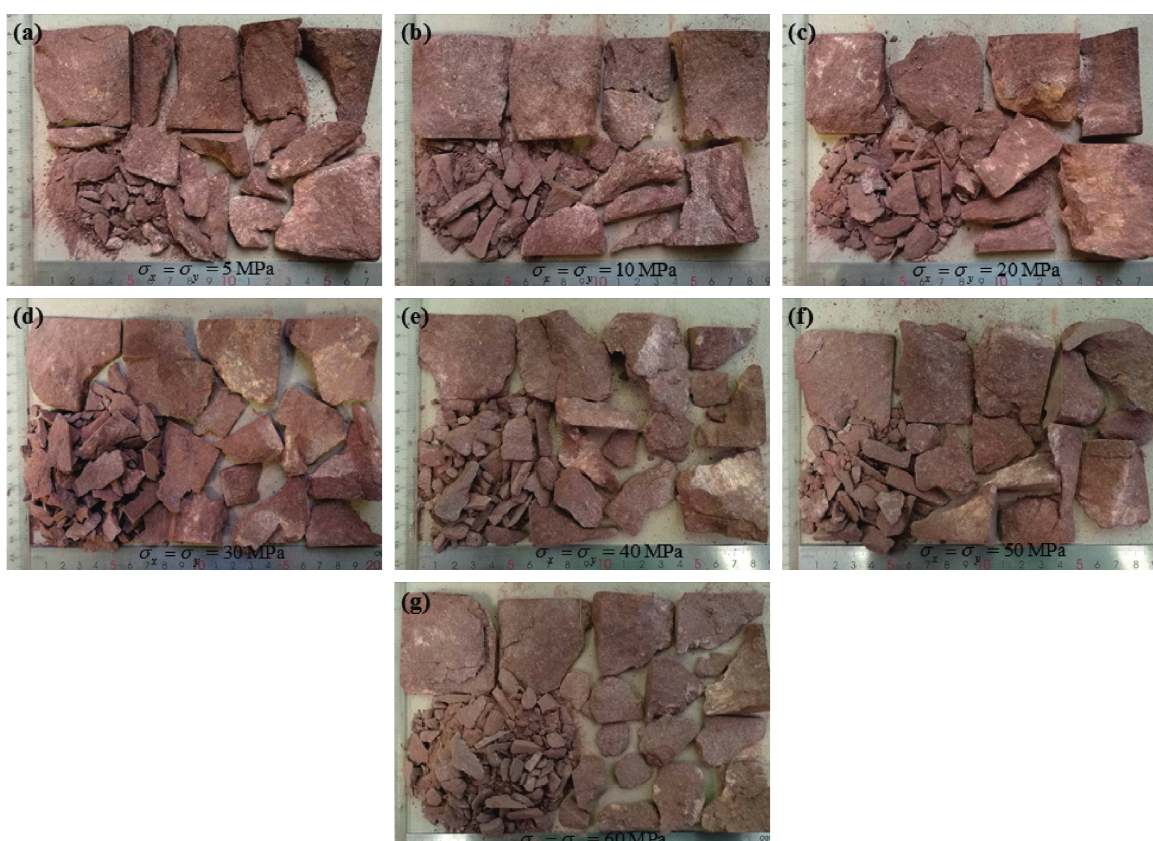
Figure 10: Failure characteristics of TLU at different confining